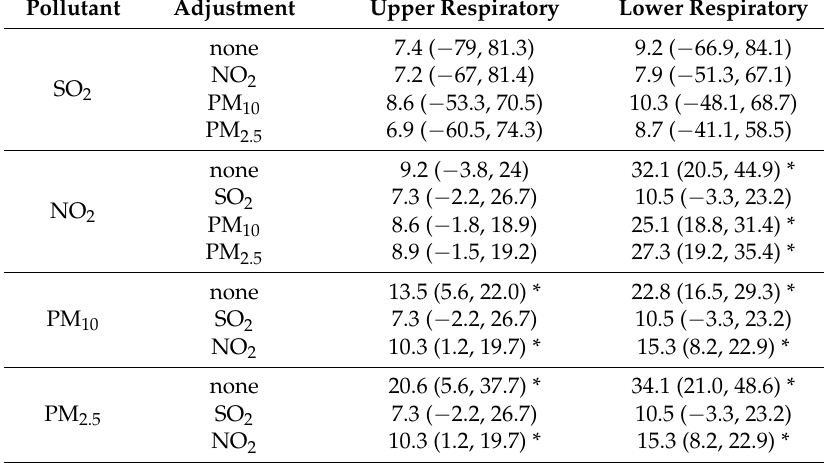
Table 5. Percent increase of total hospital admissions associated with 10 µ g/m 3 increase in air pollutants concentrations with single and multiple-pollutant models for acute respiratory infection in Shenzhen in